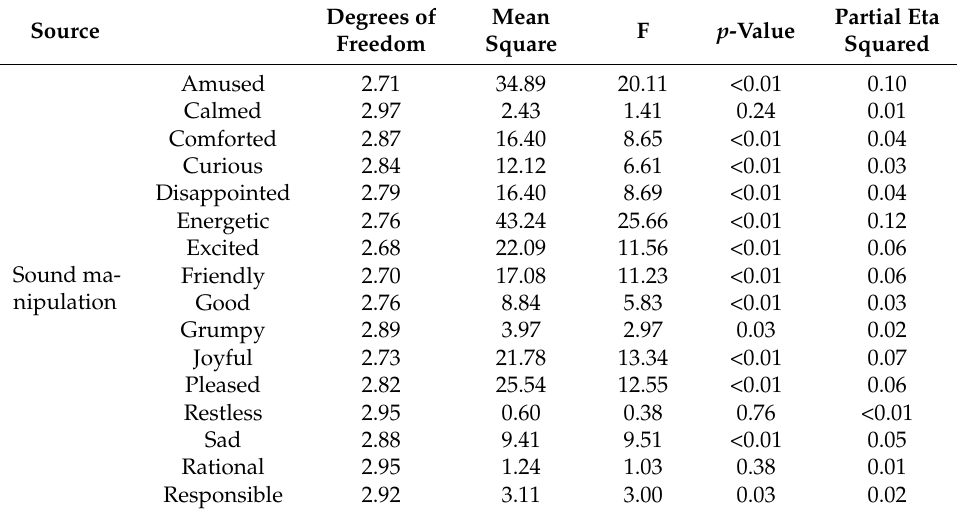
Table 1. Summary of the results of univariate tests (Greenhouse–Geisser-corrected) of Experiment 1 at the within-participants level (sound manipulation condition) on each emotion score. Degrees of Source